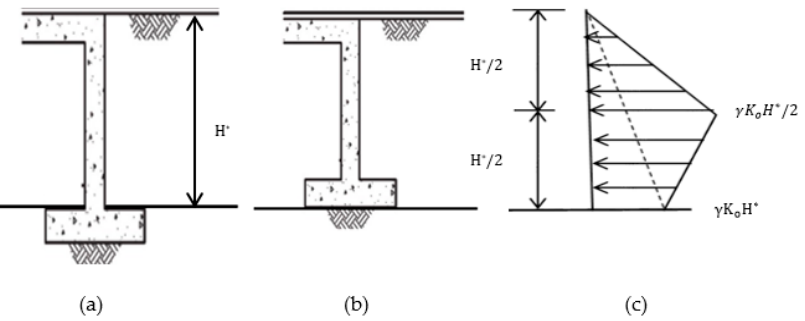
Figure 3. Earth pressure distribution on full height abutment: ( a ) rotationally rigid abutment; ( b ) rotationally flexible abutment; ( c ) earth pressure distribution.